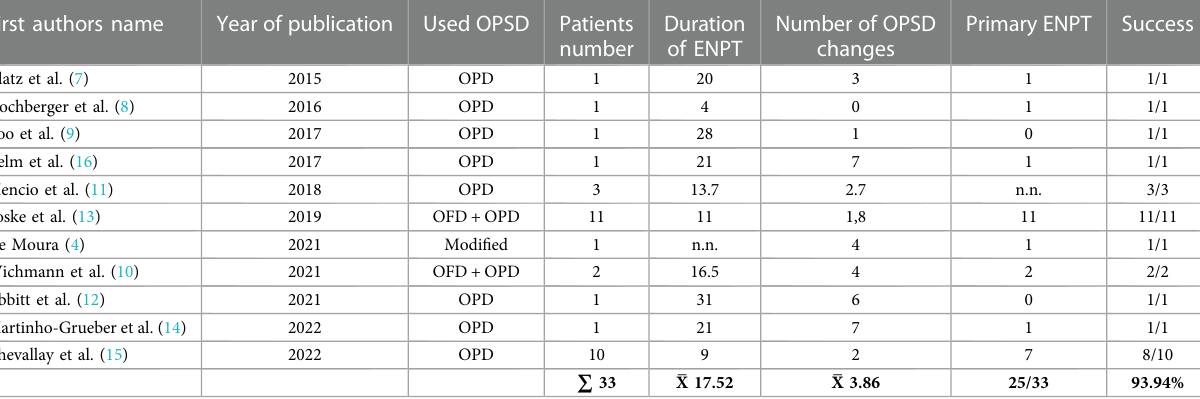
TABLE 3 Analyzed parameters of the included case